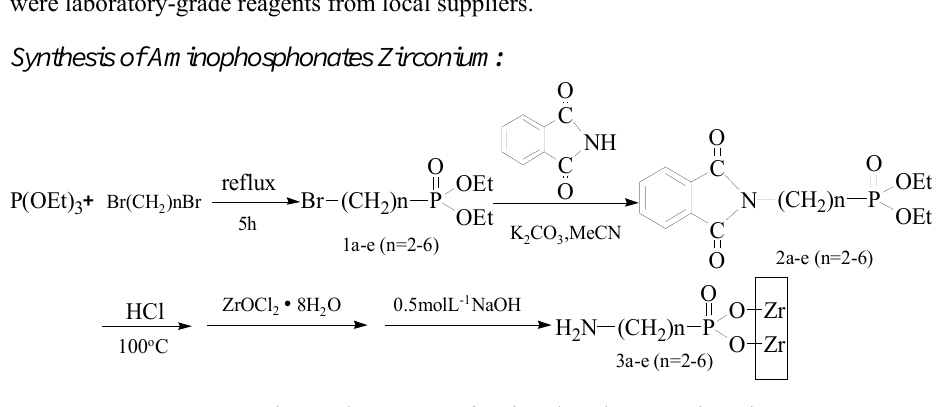
Figure 1. The synthese route of aminophosphonates